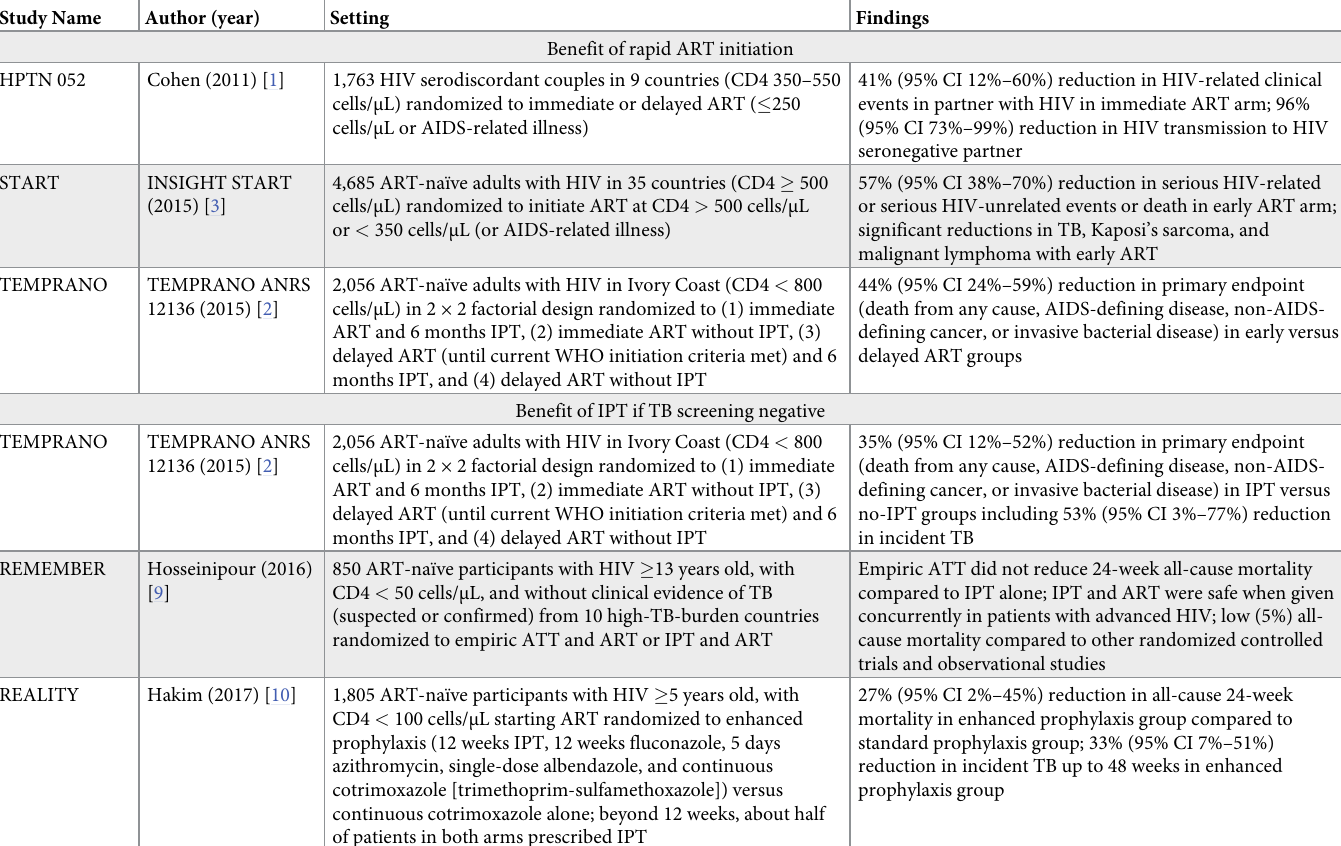
Table 1. Influential clinical studies supporting